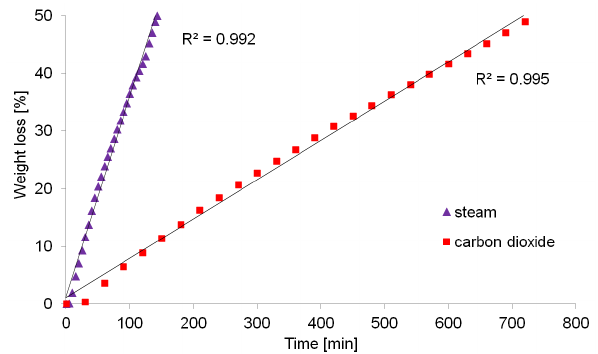
Figure 5: Weight loss of C700 as a function of reaction time during steam and carbon dioxide activation to 50% wt. burn-off (daf) at